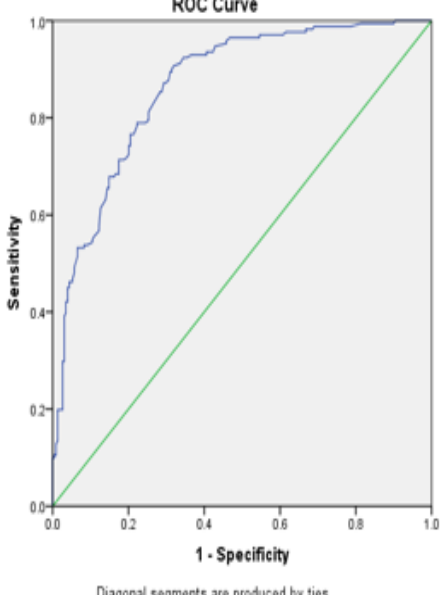
Fig. 7: ROC curve for left hand index of